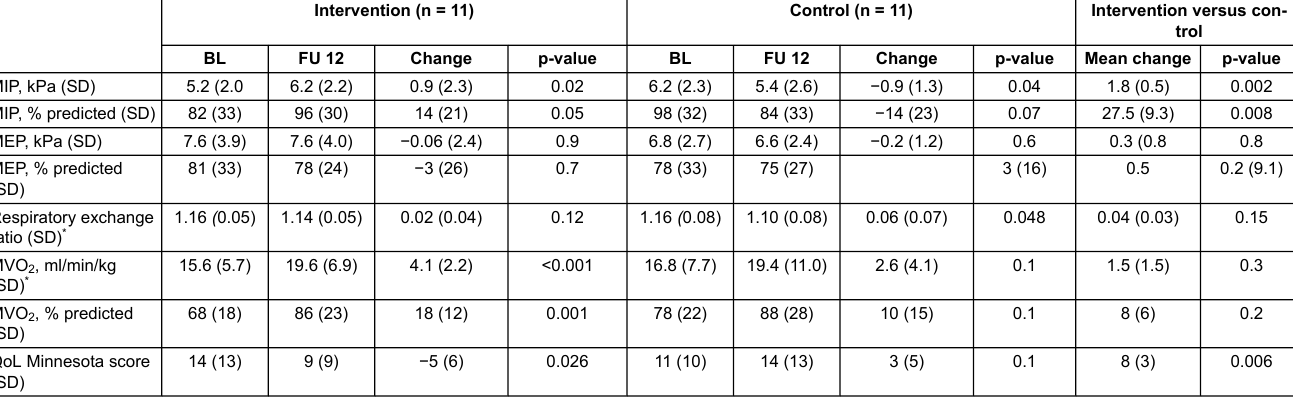
Table 2: Indices of respiratory muscle strength, cardiopulmonary exercise testing and quality of life score Intervention (n = 11) Control (n = 11) Intervention versus con-